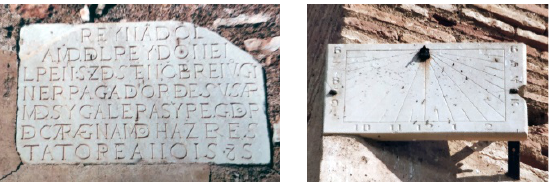
Figure 3. On the left, the marble plaque of the South facade, which is still preserved, where the date of the construction of the tower and the person who funded it appear. On the right, an image of the sundial located on the southwest corner. (General Direction,